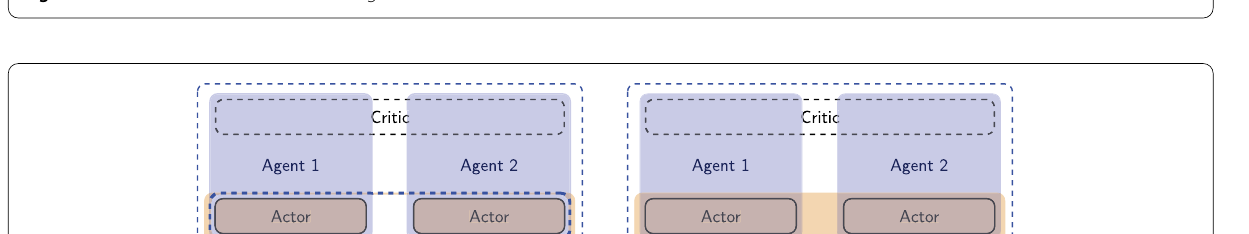
Figure 4 MARL with two communicative agents